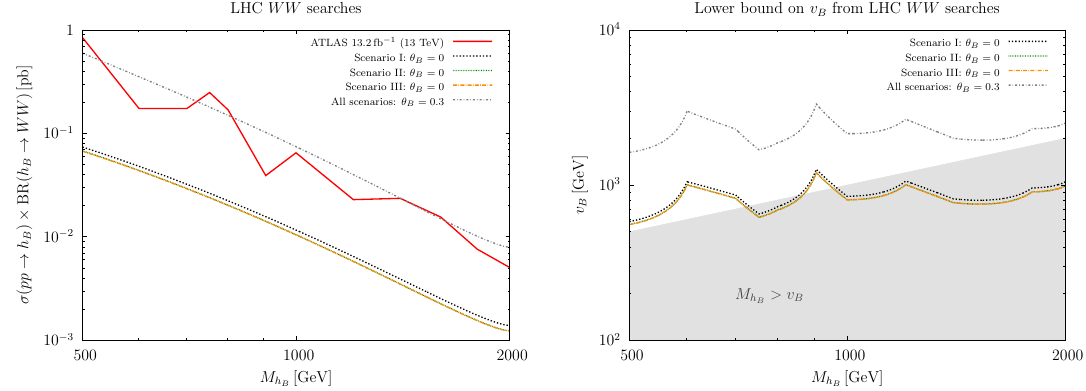
Figure 7 . Constraints from WW searches [31]. Left panel: experimental bounds as well as cross section predictions in scenarios I, II, and II as a function of the baryonic Higgs mass. Cross sections are shown both for negligible mixing angle and for a near maximal value of (cid:18) B = 0 : 3 for which the three scenarios coincide. Right panel: experimental bounds translated into lower limits on v B as a function of M h . In the left panel we use v B = 2 TeV, and in both panels n f = 3 and m Q = 1 B